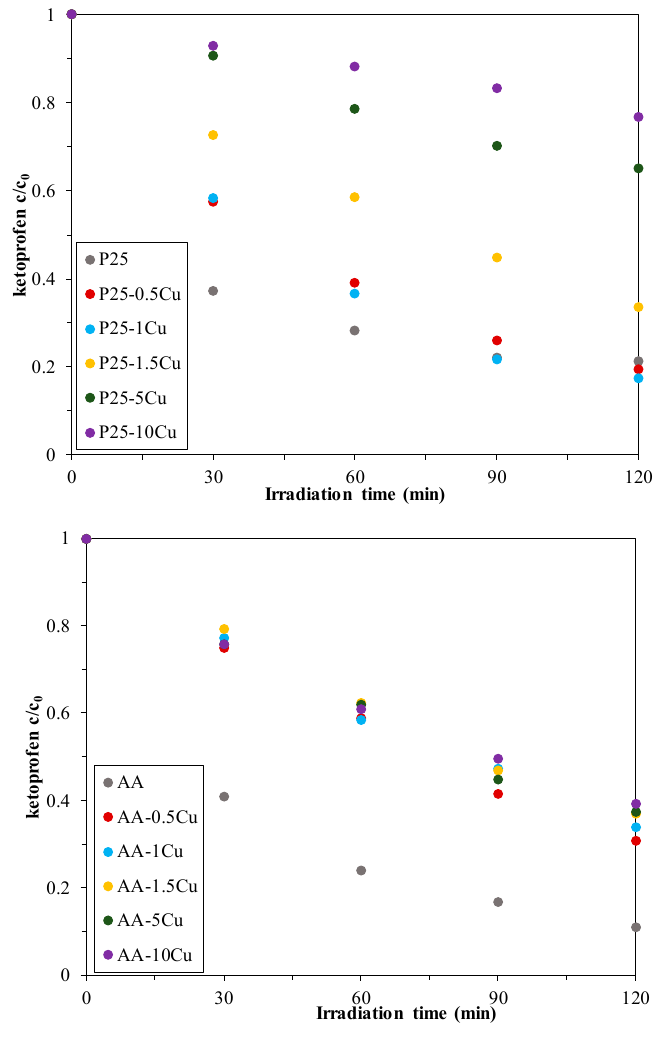
Figure 6. Degradation of ketoprofen under the irradiation of UV light—some of the composites achieved better activity than the base catalyst but only in the case of P25.